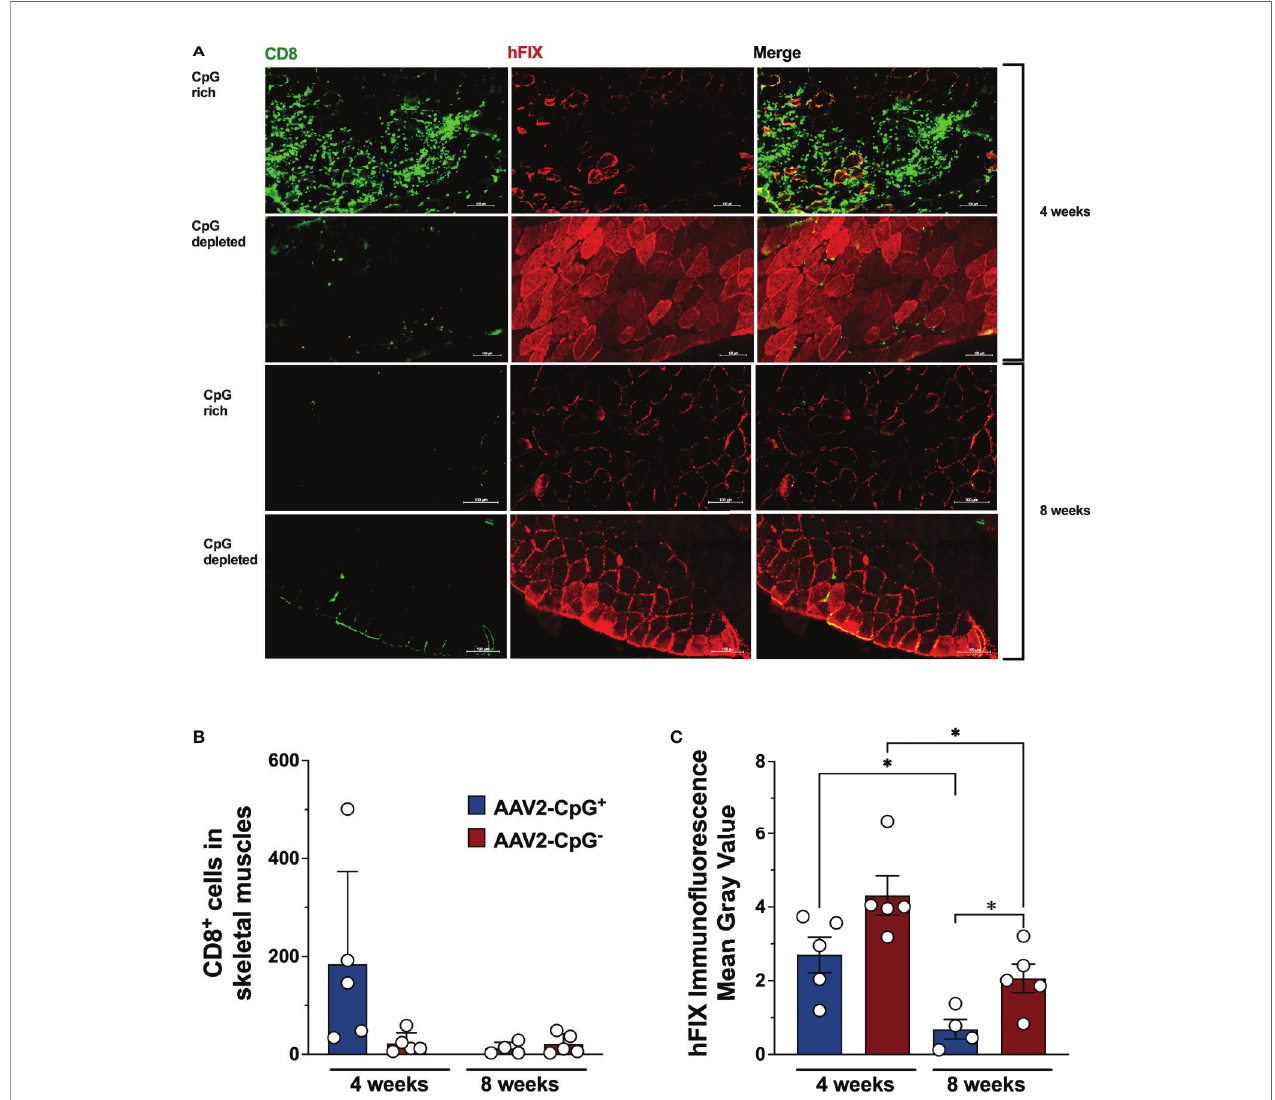
FIGURE 4 | hFIX expression and CD8 + T cell in fi ltration in transduced muscles. Skeletal muscles from hemophilia B (C3H/HeJ F9 − /Y ) mice were harvested, cryosectioned, and stained for hFIX (red) and CD8 (green) 4 weeks after AAV1-CpG − or AAV1-CpG + injection, as described in Figure 3A. Muscles section was entirely scan and images were taken for both channels using a 40× objective with ZEISS Microscopy. (A) Sequential scan image of transduced muscle from AAV1- CpG + (left) or AAV1-CpG − (right) injected mice shown for individual channel or merge image. (B) Numbers of in fi ltrating CD8 + T cells in transduced muscle as quanti fi ed by Fiji-ImageJ software after generating a grid (area per point, 1200 square pixels). Whole muscle sections were quanti fi ed. (C) Fluorescent signal for hFIX quanti fi ed as mean gray value with Fiji-ImageJ software. Representative images from fi ve mice are shown for each condition. The scale bar represents 100 m m. Data are average ± SEM of at least fi ve animals per group. Each circle represents an individual animal. Statistically signi fi cant differences are indicated. *P <